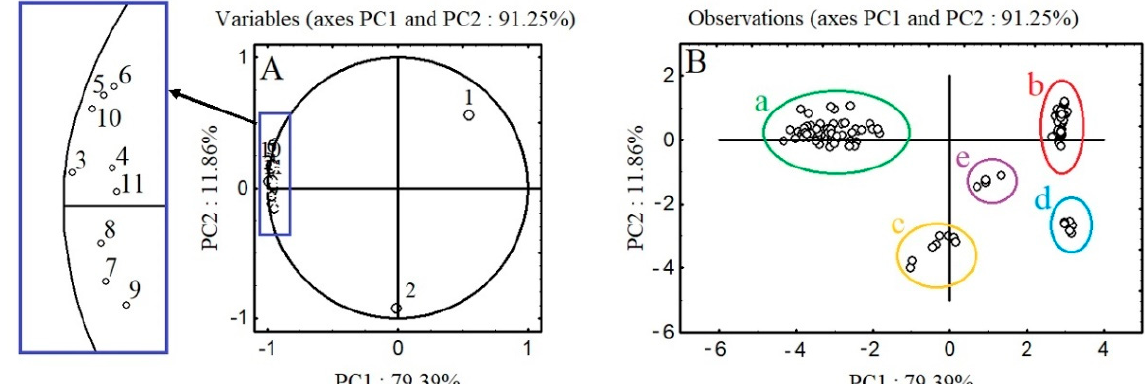
Figure 1. Principal component analysis (PC1 and PC2) of A. procera at five development stages. ( A ): The loading values of response values (polyphenols concentration) on PC1 and PC2 from PCA. ( B ): Observations on the same PCA axes. Variables: